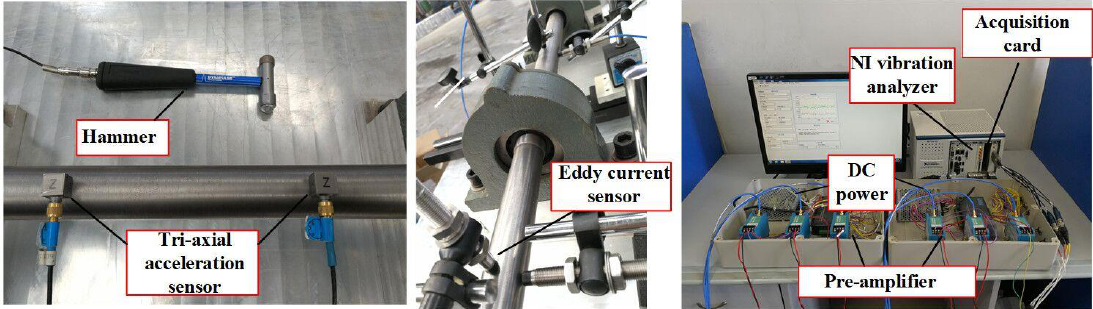
Figure 16. The dynamic response experiment setup of GCRS.